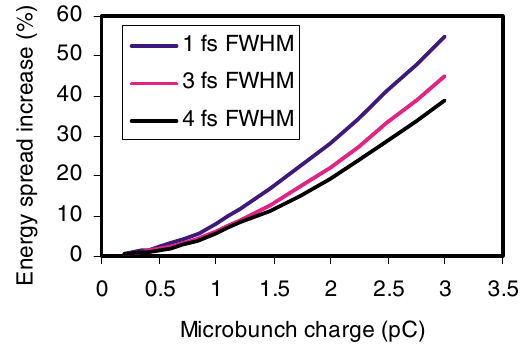
FIG. 4. (Color) Energy spread increase versus microbunch charge at different microbunch